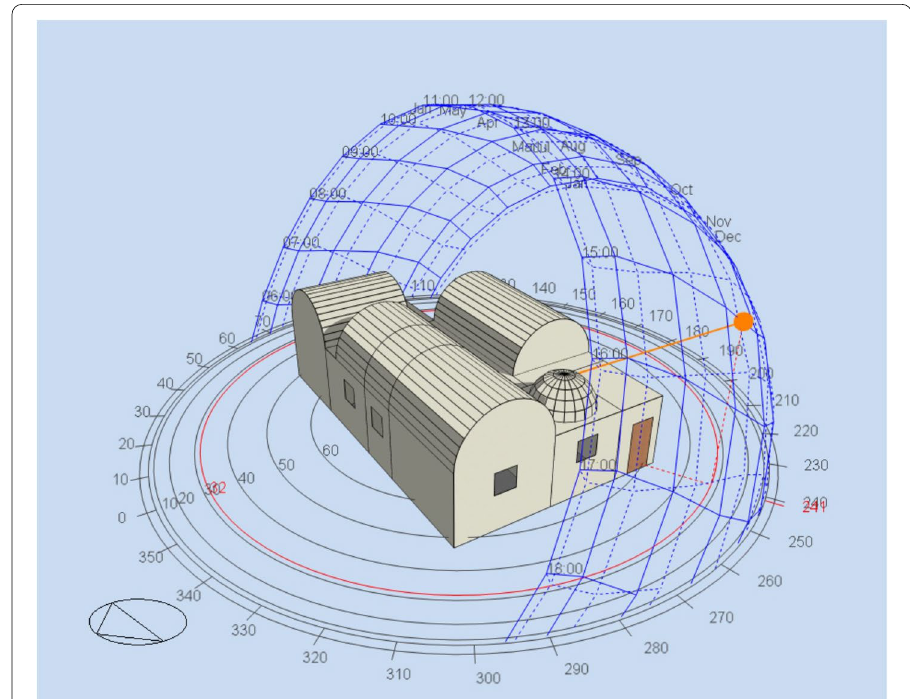
Fig. 11 Base model (BM) modelling on DesignBuilder interface with its